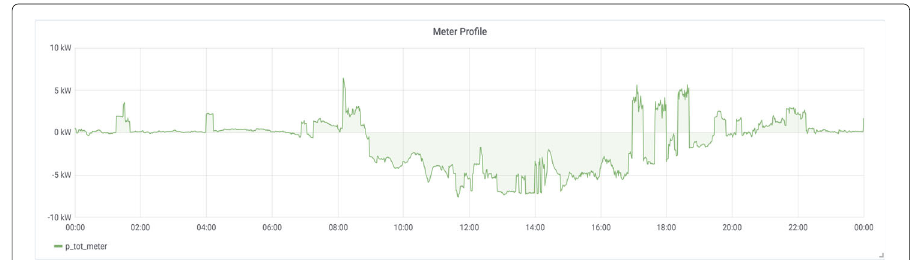
Fig. 2 Meter power profile in presence of a non-monitored PV installation